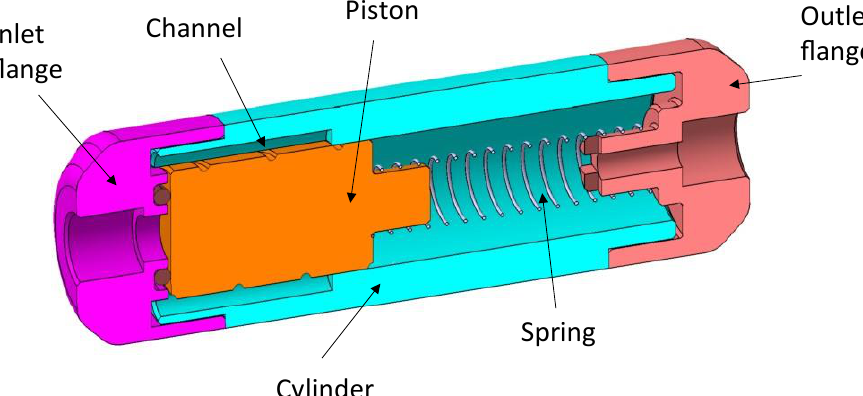
Figure 1. Cross-section of the passive constant flow valve at rest. The piston is engaged in the narrow part of the cylinder. Increasing the pressure leads to a movement of the piston to the right until the pressure force onto the piston is balanced by the spring restoring force. The fluid is forced to flow through the channel engraved into the piston.